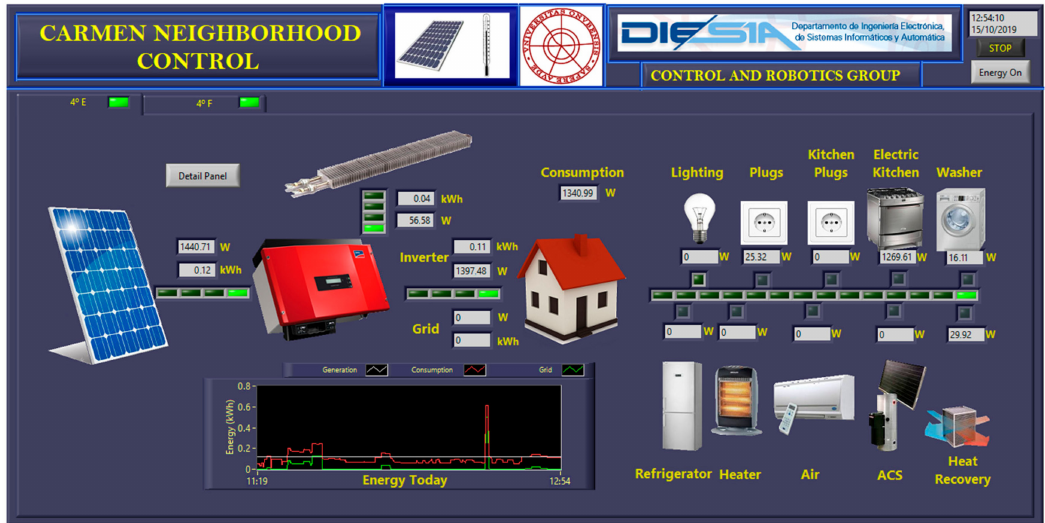
Figure 17. HAS screen. Left: Dwelling plan with measurements of temperature, relative humidity and air quality. Right: Measurements versus time for each room.